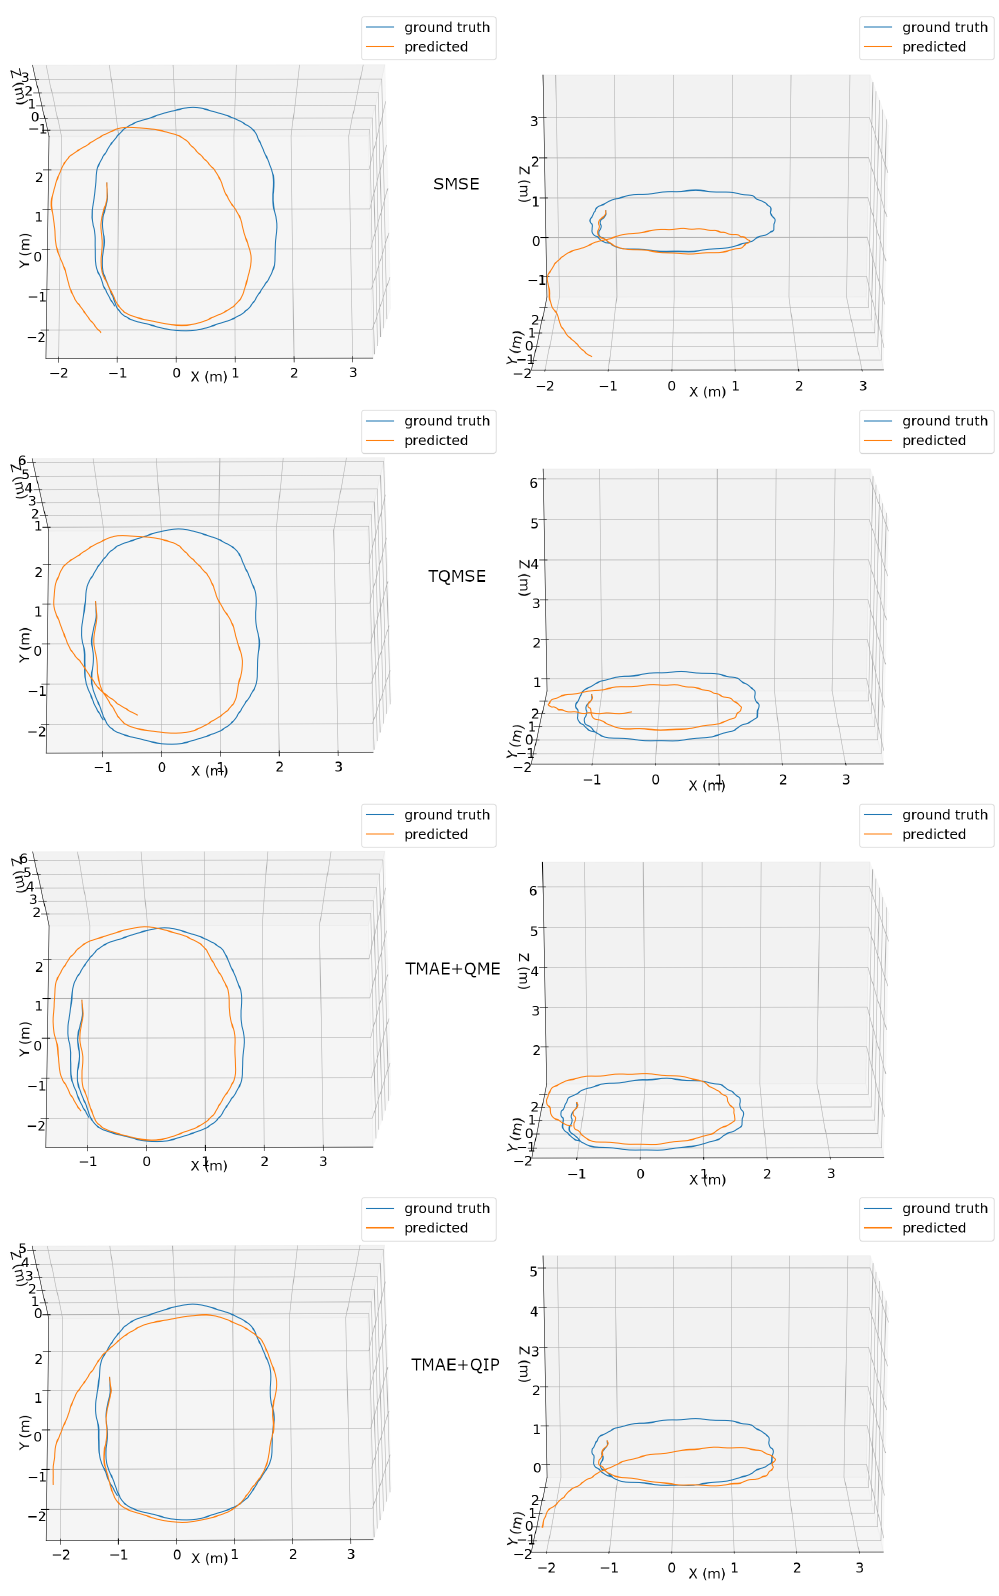
Figure 5. Top ( left column ) and side ( right column ) views of ground truth (blue) and predicted (orange) trajectories for an excerpt of the “handheld/data5/seq1” dataset using different configurations: SMSE ( first row ), TQMSE ( second row ), TMAE+QME ( third row ) and TMAE+QIP ( fourth row